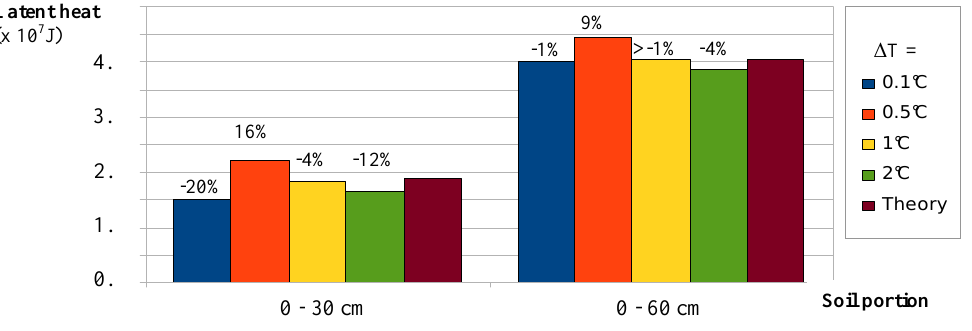
Fig. 4. Latent heat energy involved in the phase change upon the freezing of the uppermost 30 (left) and 60 (right) cm of the soil for different ORCHIDEE simulations referenced by the width of their freezing window (0.1 to 2 ◦ C), and theoretically calculated for the corresponding water amount (Theory: this corresponds to the latent heat calculated by the Stefan solution). The relative error to Theory is mentioned at the top of each simulation